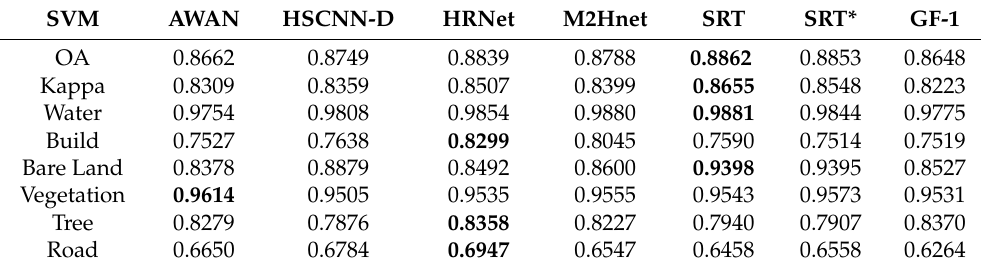
Table 7. Accuracy of classification result of Area2 with SVM. The best results are shown in bold.